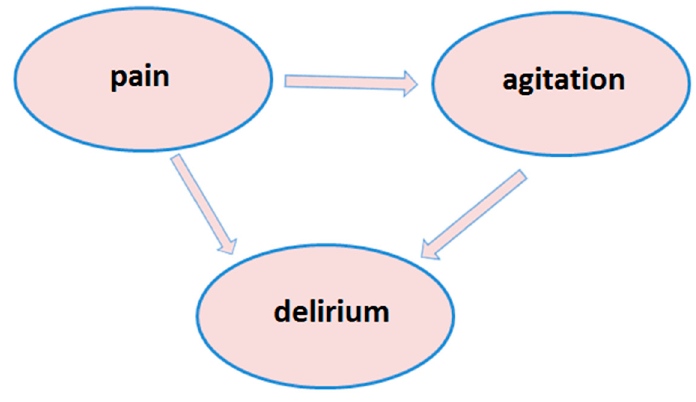
Figure 3. The Pain, Agitation, and Delirium (PAD) bundle [11].